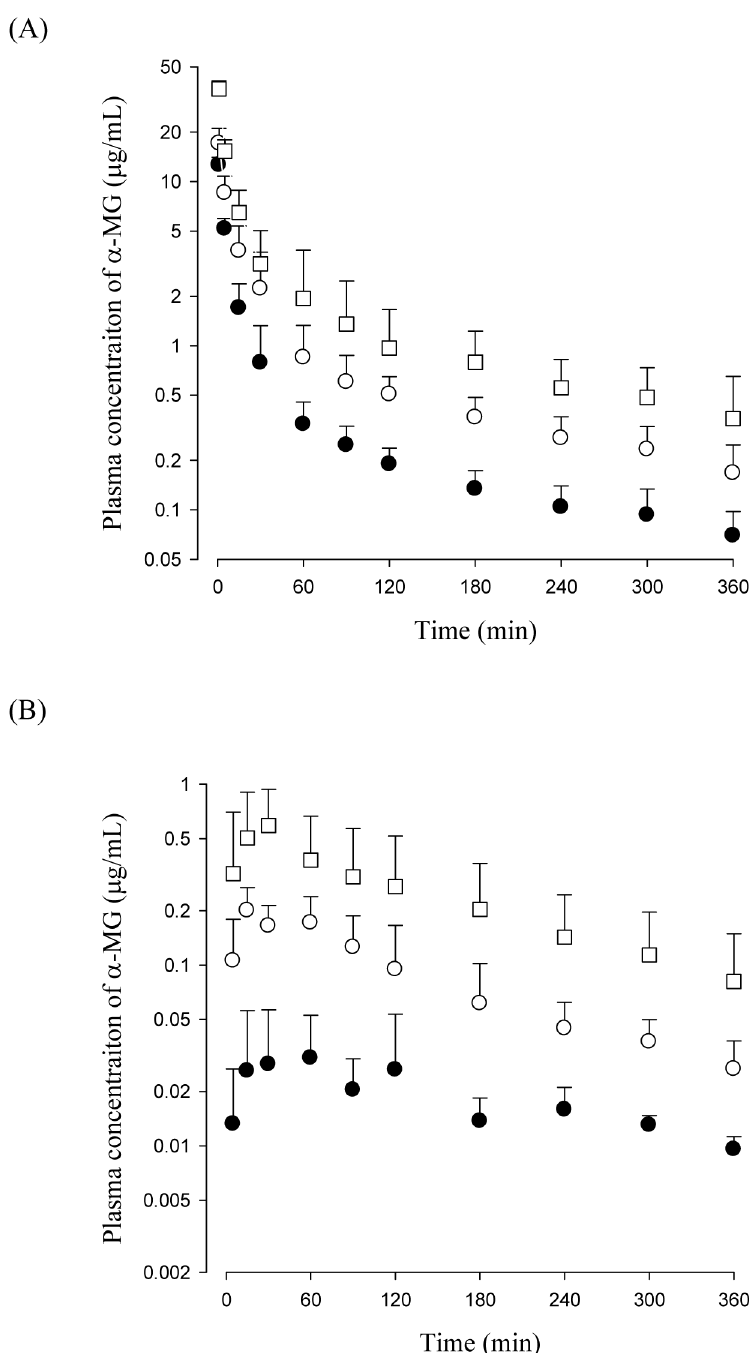
Fig 1. Mean plasma concentration of α -MG after intravenous administration of α -MG at doses of 5 ( ● ), 10 ( (cid:2) ) and 20 ( □ ) mg/kg to mice (A). Also plasma concentration of α -MG after oral administration of α -MG at doses of 10 ( ● ), 50 ( (cid:2) ) and 100 ( □ ) mg/kg to mice (B). Bars represent SDs.